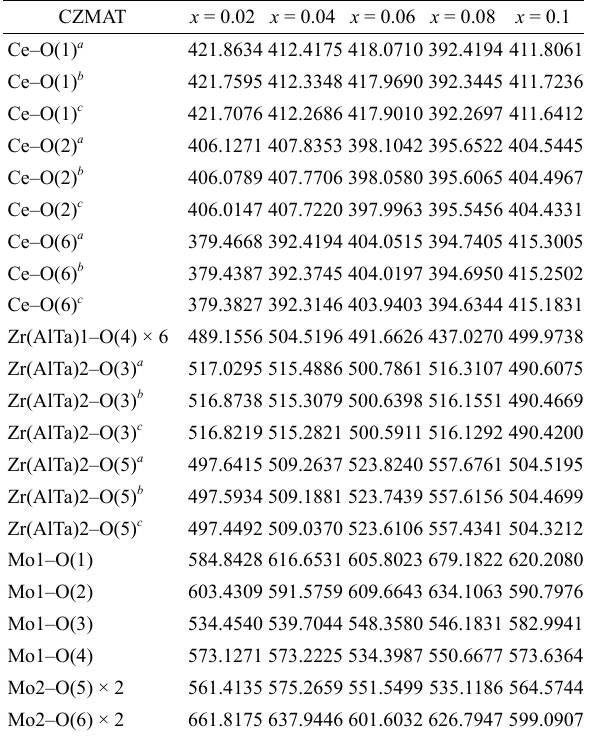
Table 6 Bond energies E of CZMAT ceramics sintered at densification temperature for 6 h (Unit: